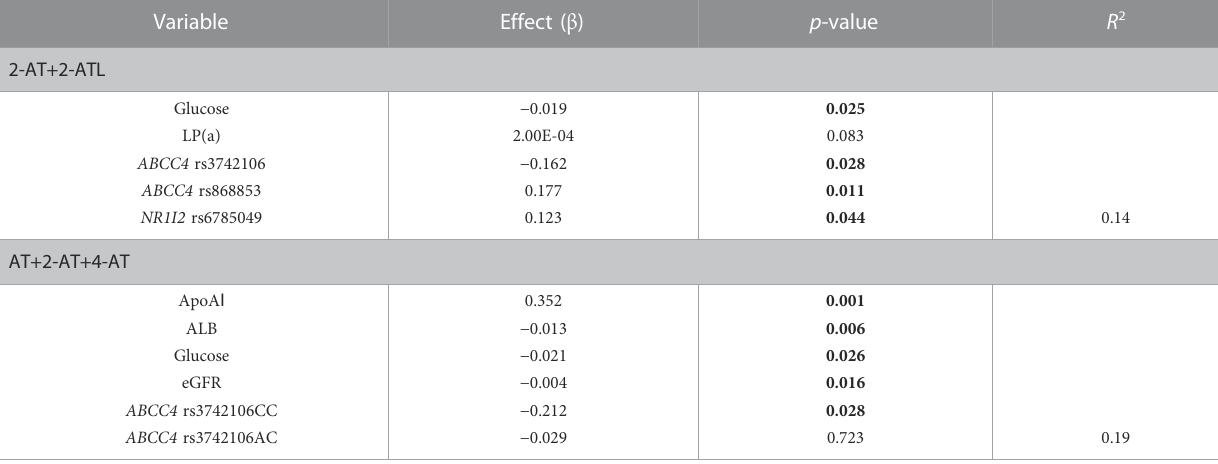
TABLE 6 Plasma atorvastatin and its metabolite concentrations-linear regression model coef fi cients.